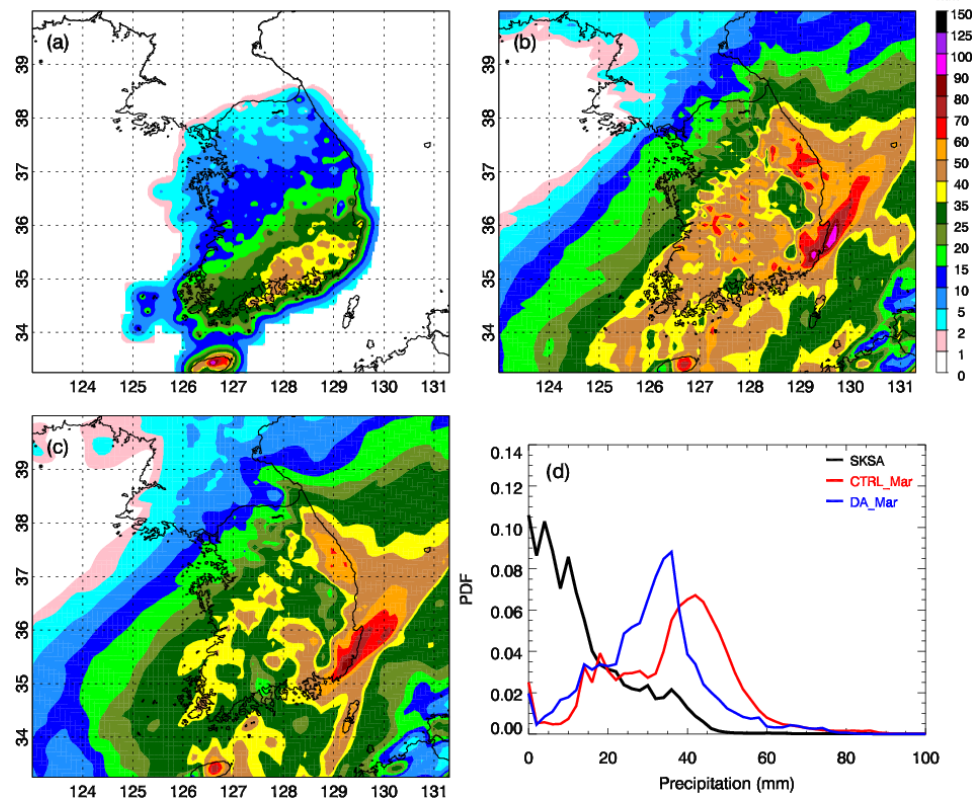
Figure 11. 24h accumulated precipitation (mm) from (a) South Korean Surface Analysis, (b) CTRL_Mar, and (c) DA_Mar, from 06:00UTC 7 March to 06:00UTC 8 March 2018 and (d) the probability density function of 24h accumulated precipitation.